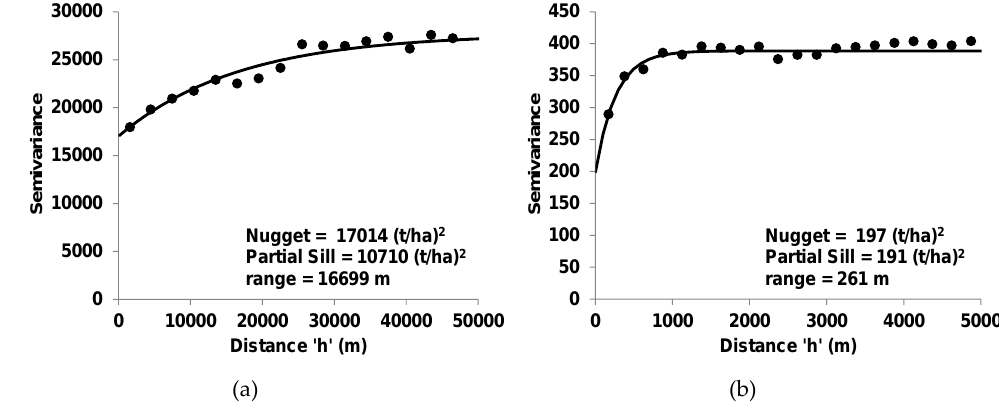
Figure 5. Variograms of the additional correction factors with the associated parameters (nugget, partial sill, and range). ( a ) Eastern ecoregion; ( b ) western and southern ecoregions. The feasibility of the OK to improve Vieilledent’s AGB map was assessed by analyzing the evolution in the accuracy of Vieilledent’s AGB map after the integration of GLAS data. This evolution was determined by comparing the precision of Vieilledent’s AGB map to that of the improved AGB map (Vieilledent’s AGB map with the integration of GLAS data). As for the improved AGB map, the precision of Vieilledent’s AGB map was calculated using AGB pixels that cover at least two in situ AGB values. The precision of Vieilledent’s AGB map and the improved AGB map were calculated using 128 samples (each sample was obtained by averaging at least two in situ AGB values). These samples are located in all ecoregions and have values within the range of in situ AGB used to build the models relating in situ AGB to both GLAS and DEM metrics (Figure 6). Figure 6a shows the AGB from Vieilledent’s AGB map as a function of the average in situ AGB. Similarly, the comparison between the AGB from the improved AGB map and the average in situ AGB is shown in Figure 6b. The results show that the OK decreased the RMSE of Vieilledent’s AGB map by 6.9 t/ha; the RMSE of the improved AGB map is 74.1 t/ha (R 2 = 0.71, RRMSE = 28.2%) compared to an RMSE of 81.0 t/ha (R 2 = 0.62, RRMSE = 30.8%) for AGB estimates from Vieilledent’s AGB map.